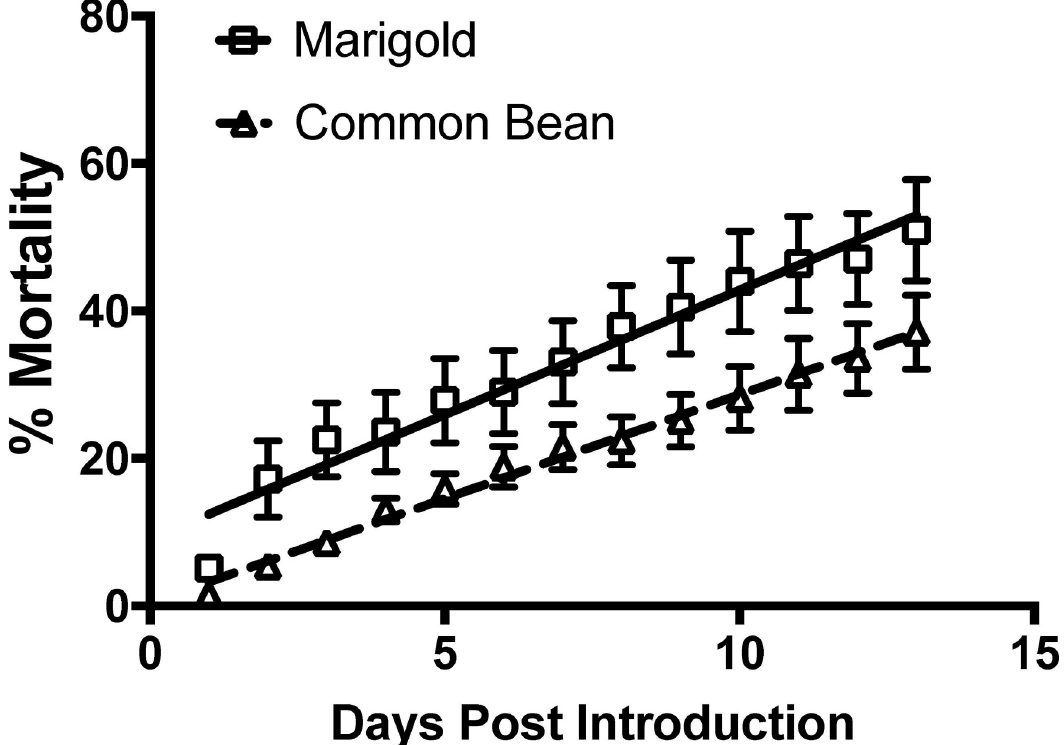
Fig 2. Mortality for adult Lygus hesperus on Tagetes patula L. (marigold) and Phaseolus vulgaris L. (common bean). Lines indicate the linear regressions and bars represent standard errors.